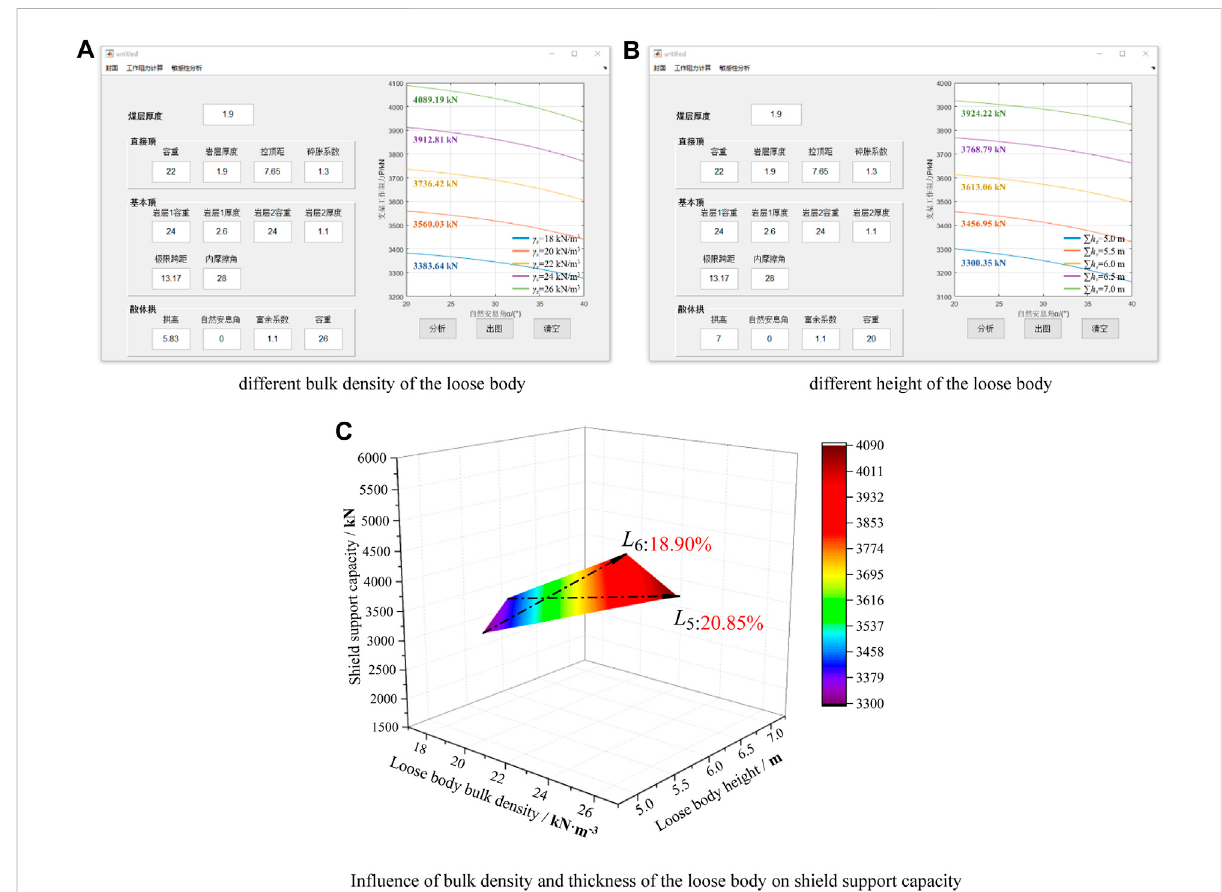
FIGURE 11 Relationship between related parameters of the loose body and shield support capacity.